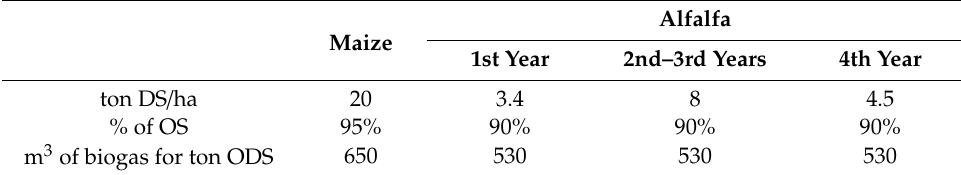
Table 1. Yields of maize and alfalfa.